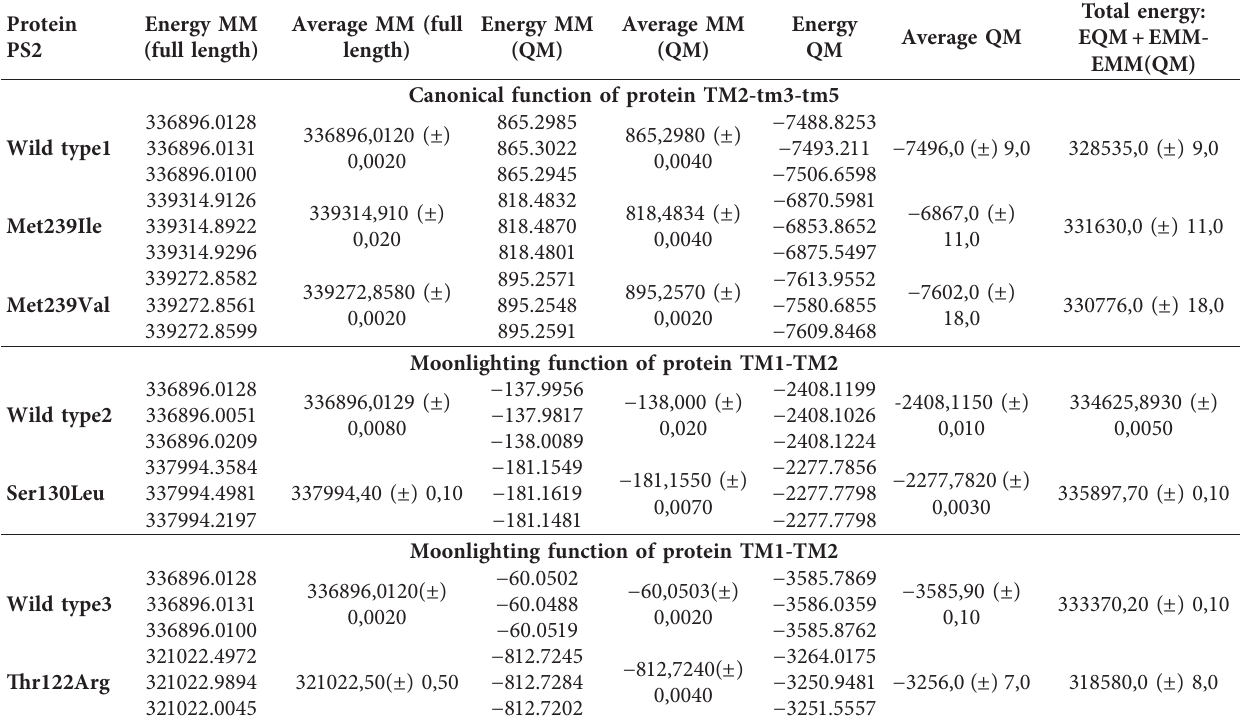
Table 2: Energy values calculated in the system with PS1 in the c -secretase